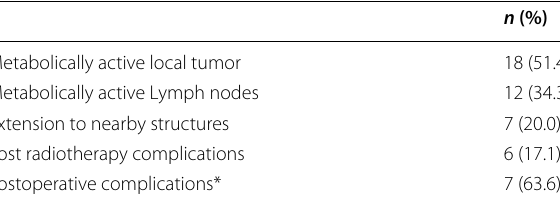
Table 2 PET CT findings of the studied patients